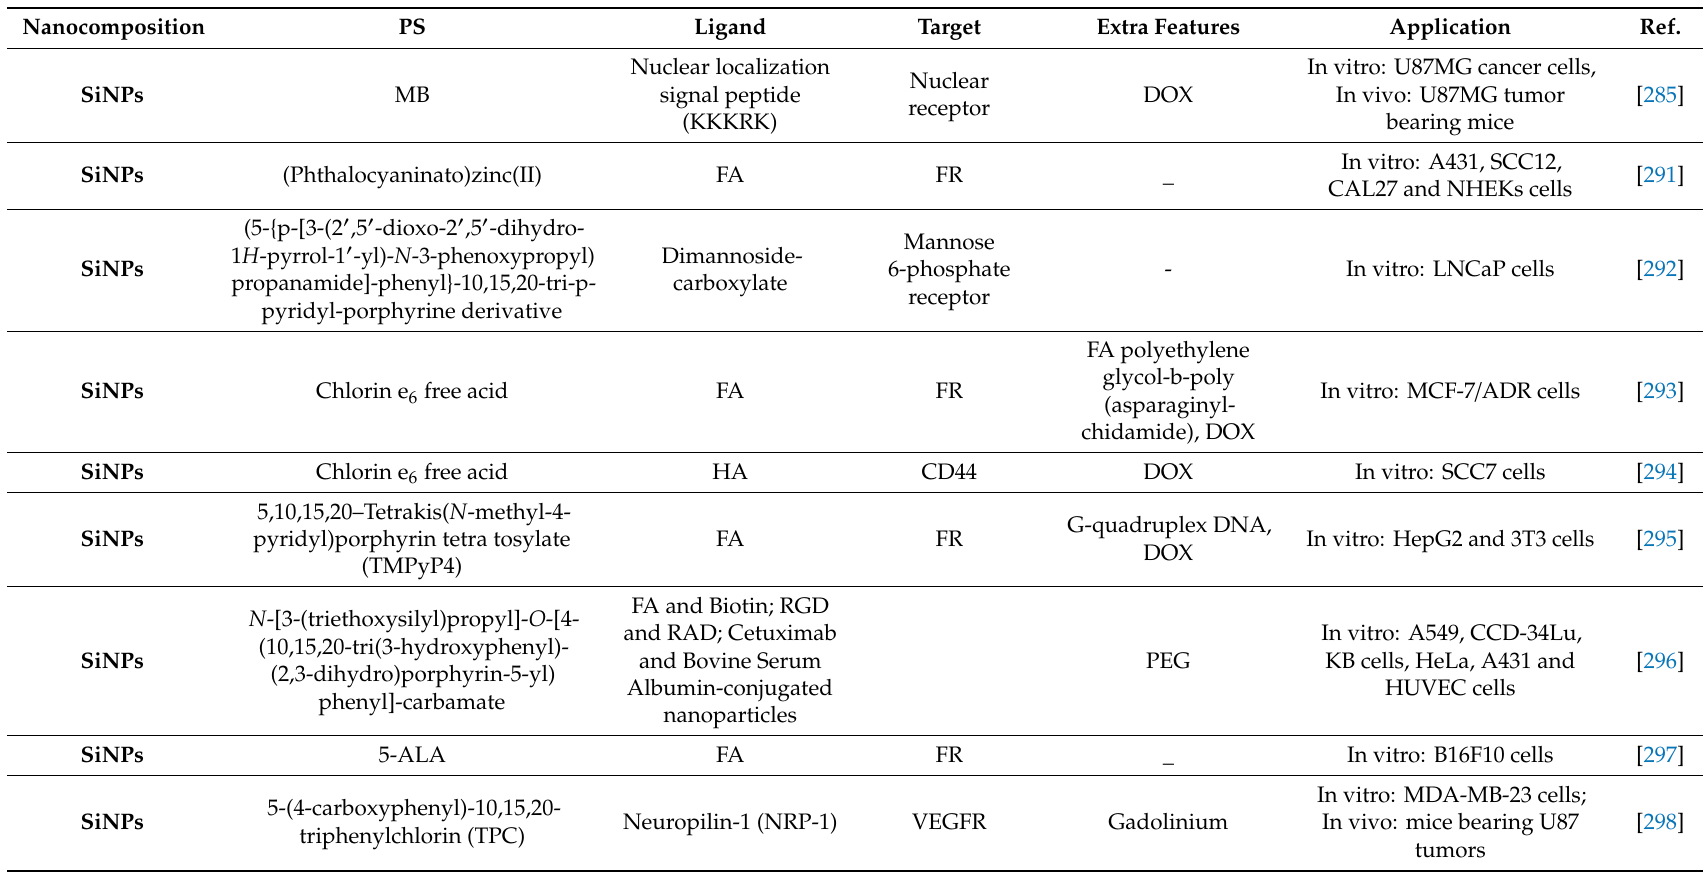
Table 8. Examples of ligand-targeted inorganic nanoparticles (INPs) and metal organic frameworks (MOFs) for PDT.